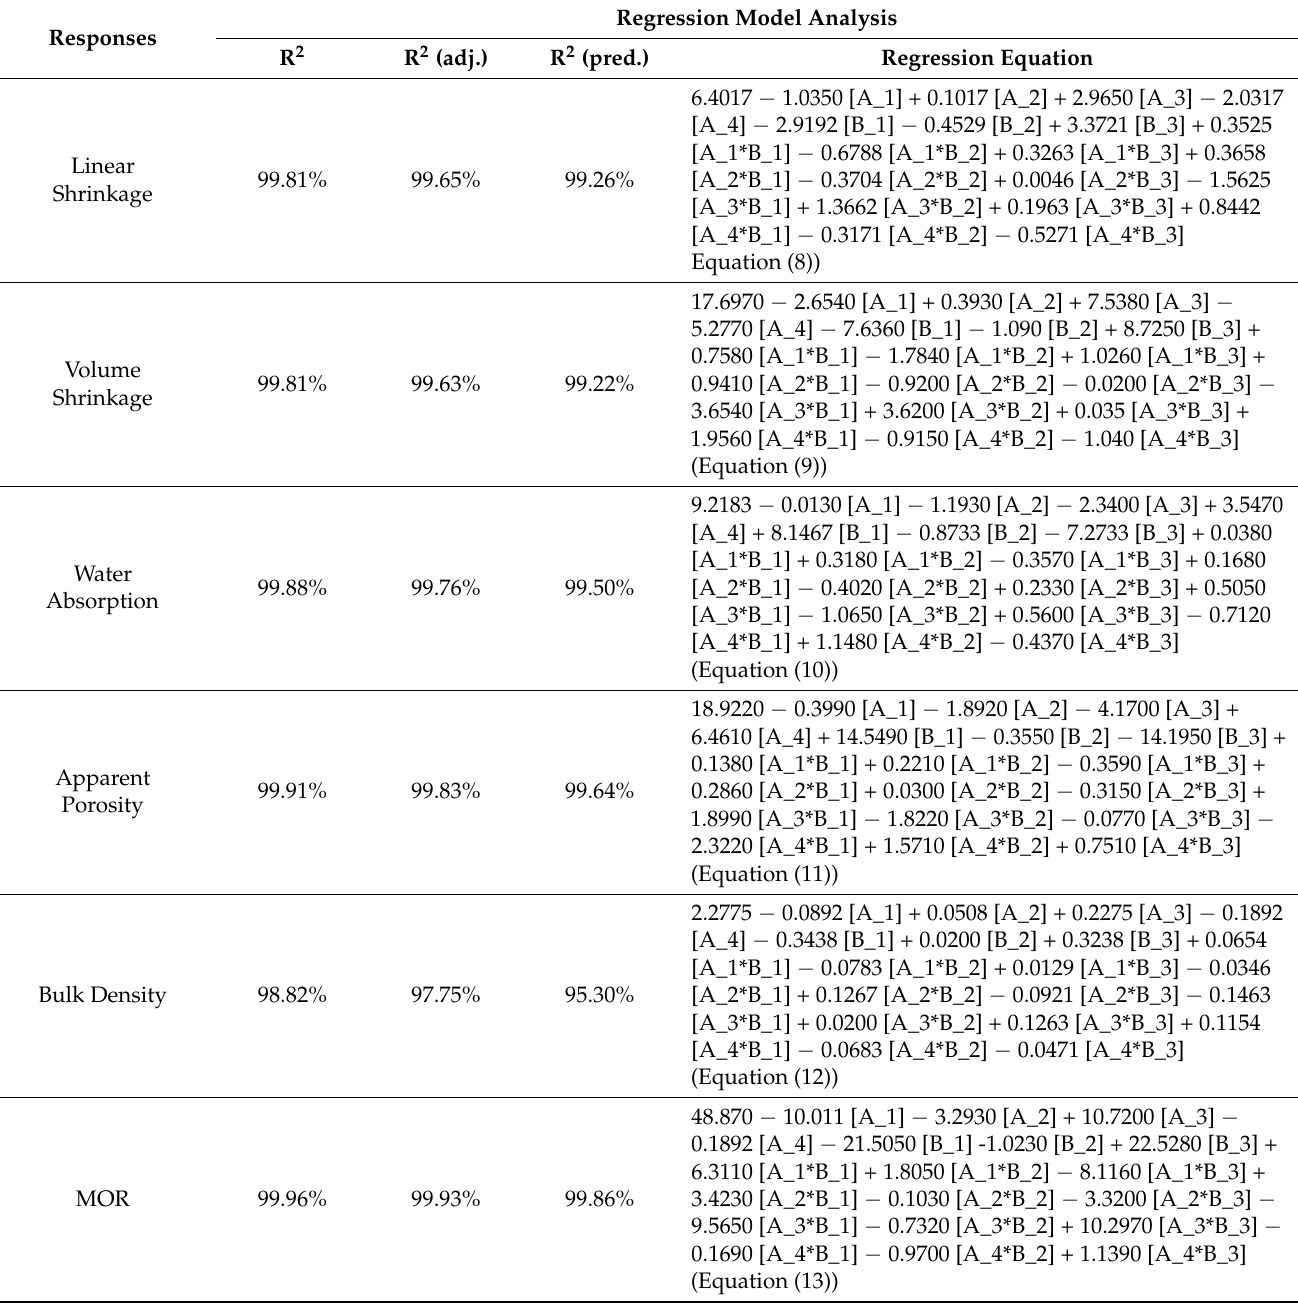
Table 5. Regression model analysis of linear shrinkage, volume shrinkage, water absorption, apparent porosity, bulk density and